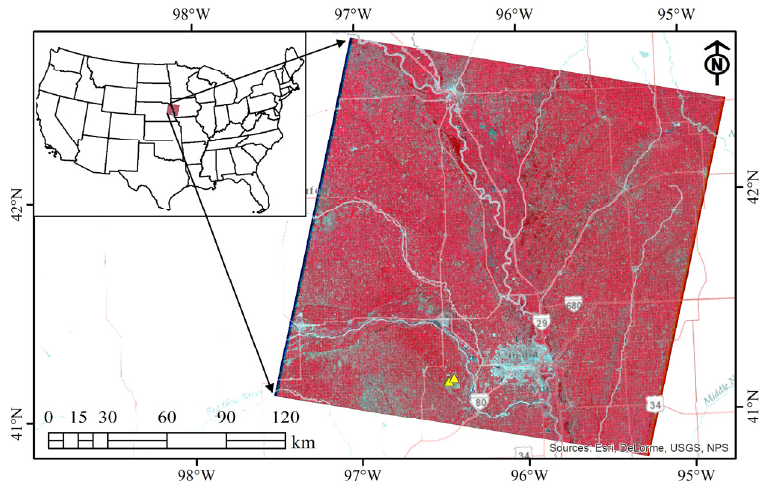
Figure 1. Location map of the study area for Landsat path 28, row 31. Eddy covariance sites are also shown using yellow triangles just southwest of Omaha, Nebraska, (blue-gray color) in the lower middle part of the image.